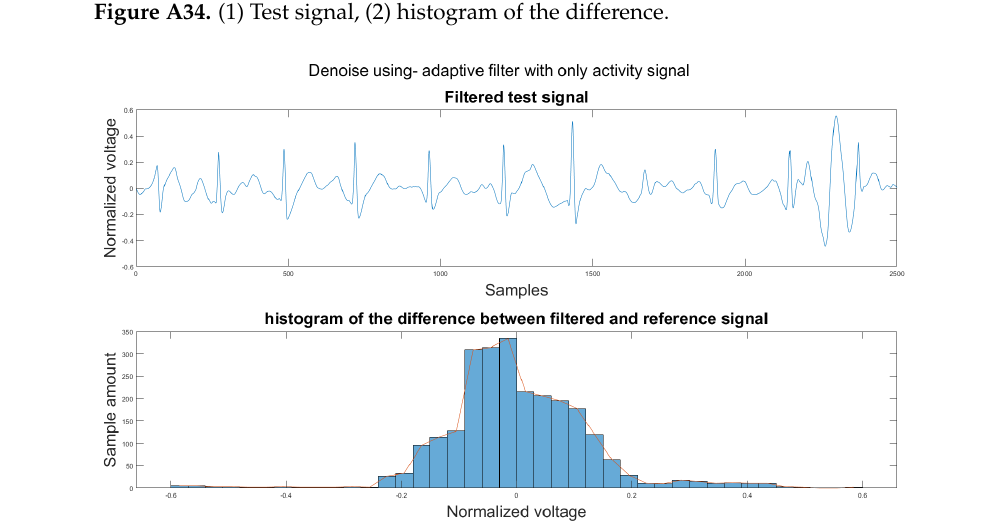
Figure A35. (1) Test signal, (2) histogram of the